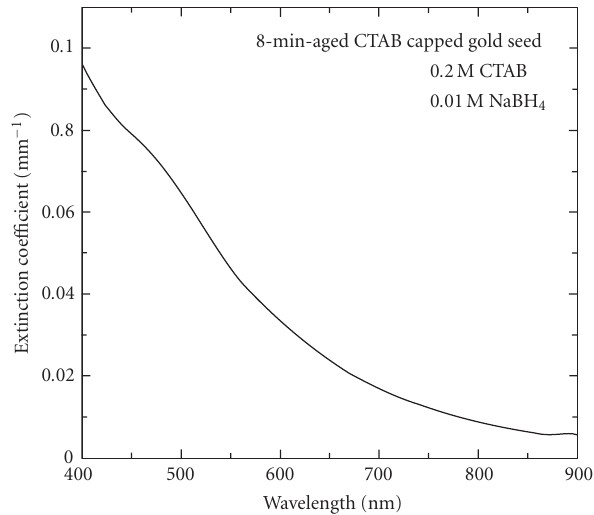
Figure 1: Optical extinction spectrum of preformed 8-minute-aged CTAB-capped gold nanospheres as seed for nanorod